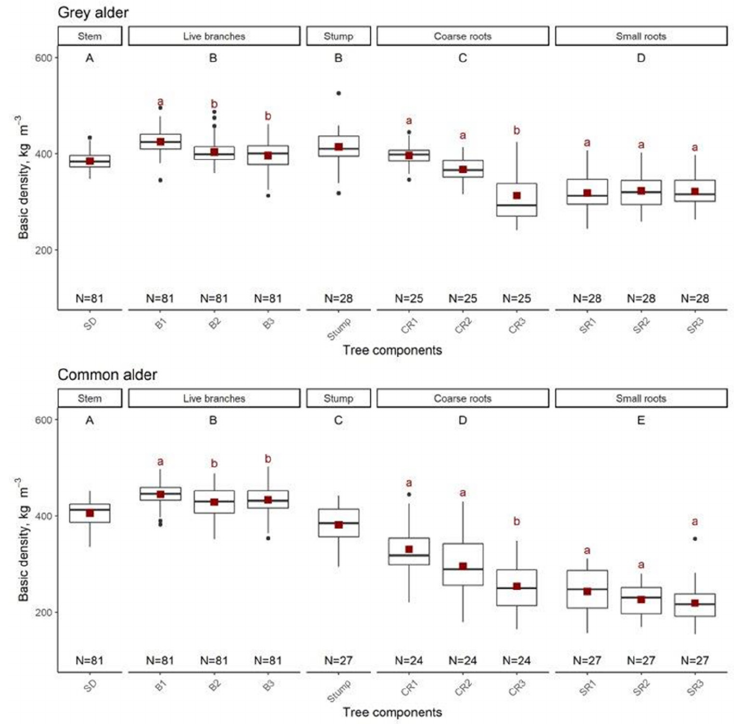
Figure 2. Basic density of aboveground and belowground tree components of gray alder ( A. incana (L.) Moench) and common alder ( A. glutinosa (L.) Gaertn.) (abbreviations: see Table 2). The boxplot displays the median (bold line), mean (dark red square), lower and upper quartiles (box), minimal and maximal values (whiskers), and outliers (black dots). Different capital letters show statistically significant differences ( p < 0.05) between components, while different small letters indicate differences among tree components within the same tree species. N represents the number of samples in each group. Table 2. Average (mean ± standard error) basic density (in kg m − 3 ) for the aboveground and below- ground tree components of gray alder and common alder.